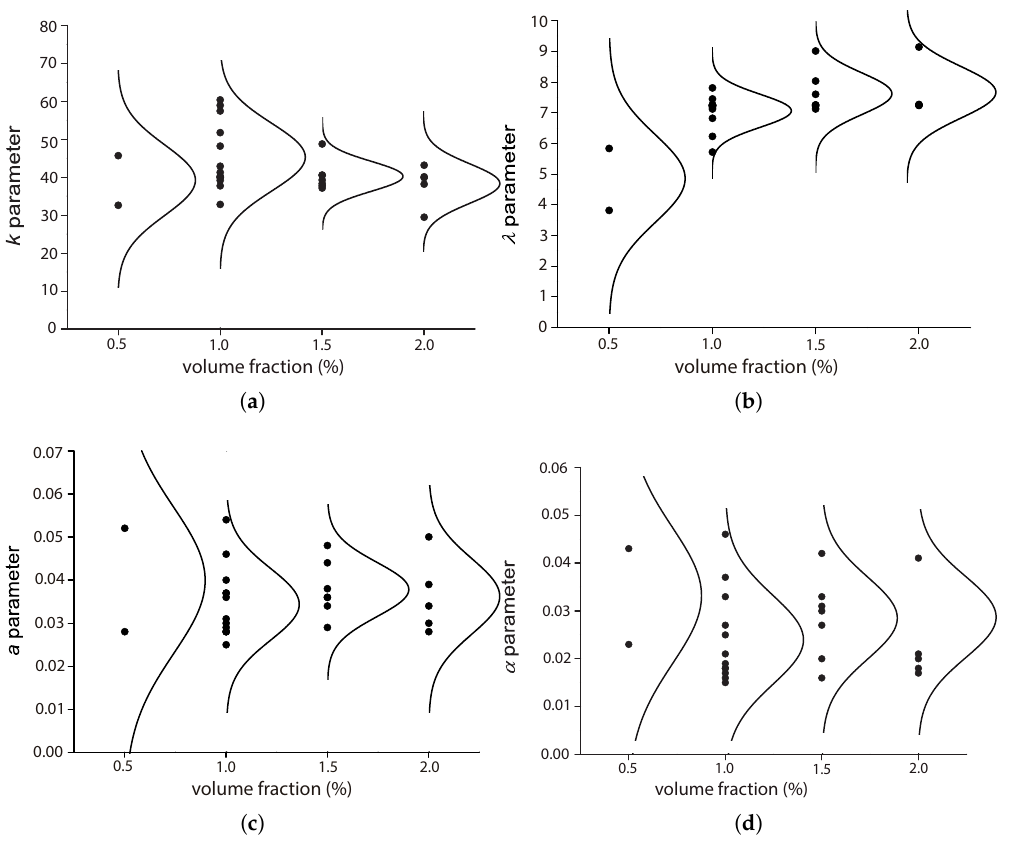
Figure 14. A global perspective of the influence of fiber volume fraction on parameters ( a ) k ; ( b ) λ ; ( c ) a and ( d ) α